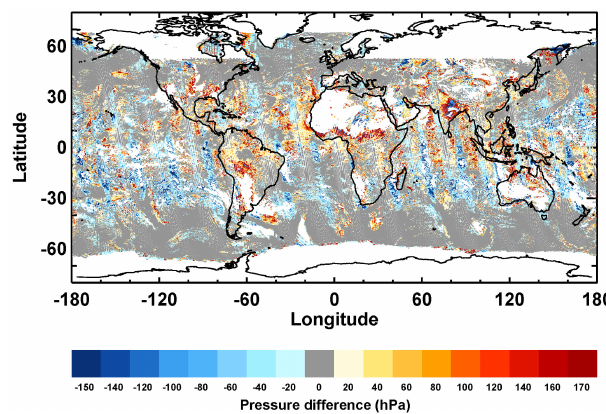
Figure 12. Cross-track dependence of ECF zonal means retrieved with GLER (black) and climatological LER (red) for different lati- tude bins. Data are for 13 November 2006; effective cloud fractions are between 0.05 and 0.25.